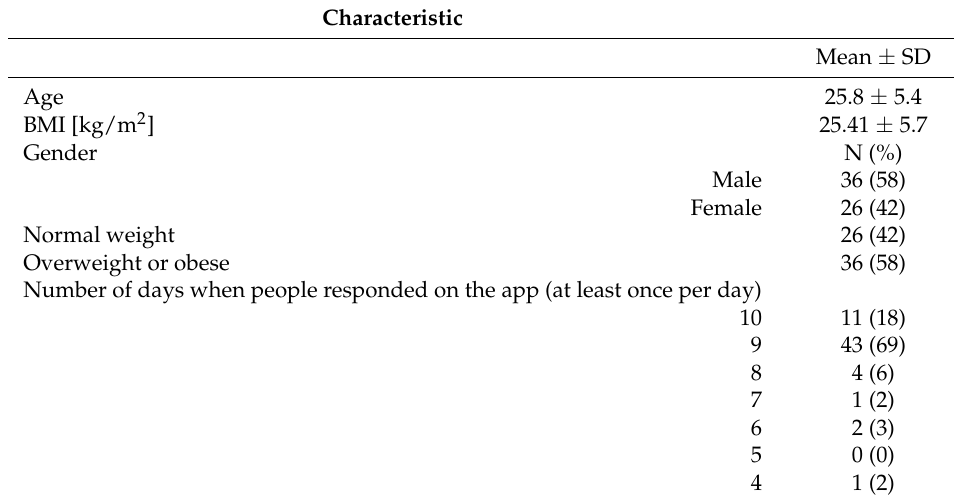
Table 1. Characteristics of the study